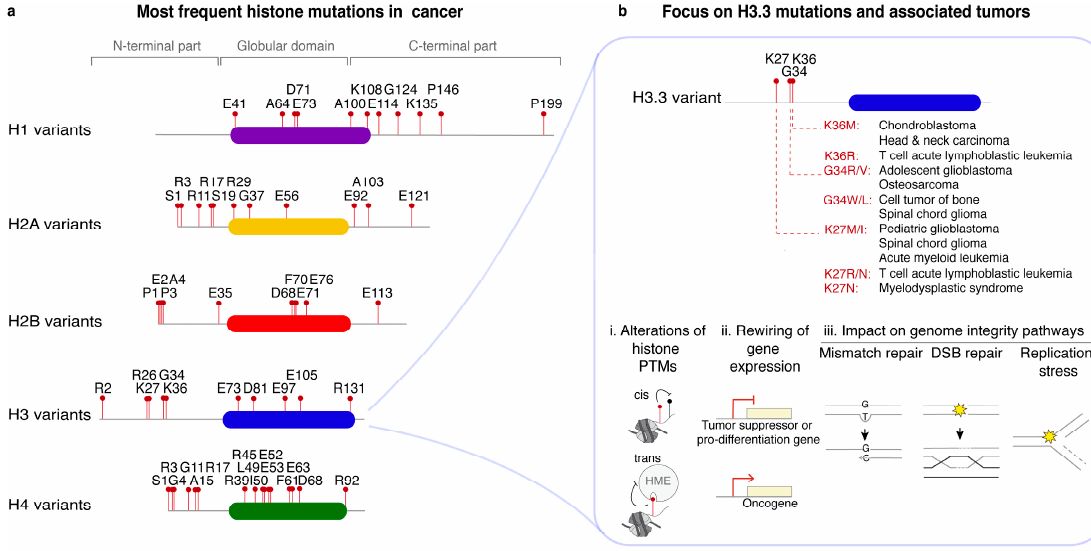
Figure 4. Histone variant point mutations in cancer. ( a ) The ten most frequently mutated residues in each histone family are shown as red lollipops using the single-letter aminoacid code (source [6], Catalogue Of Somatic Mutations In Cancer database [114] (http: // cancer.sanger.ac.uk / cosmic). The positions refer to the mature proteins, which lack the initial methionine. Colored bars represent the globular domains of histone proteins. ( b ) Top , The most frequent missense mutations in the H3.3 variant are indicated in red, next to the associated tumor types. Bottom , Proposed oncogenic mechanisms relying on three types of molecular changes induced by H3.3 mutations. Histone post-translational modifications (PTMs) including methylation and acetylation are a ff ected in cis (on the same histone molecule) or in trans (through inhibition of histone modifying enymes (HME)). Gene expression programs are